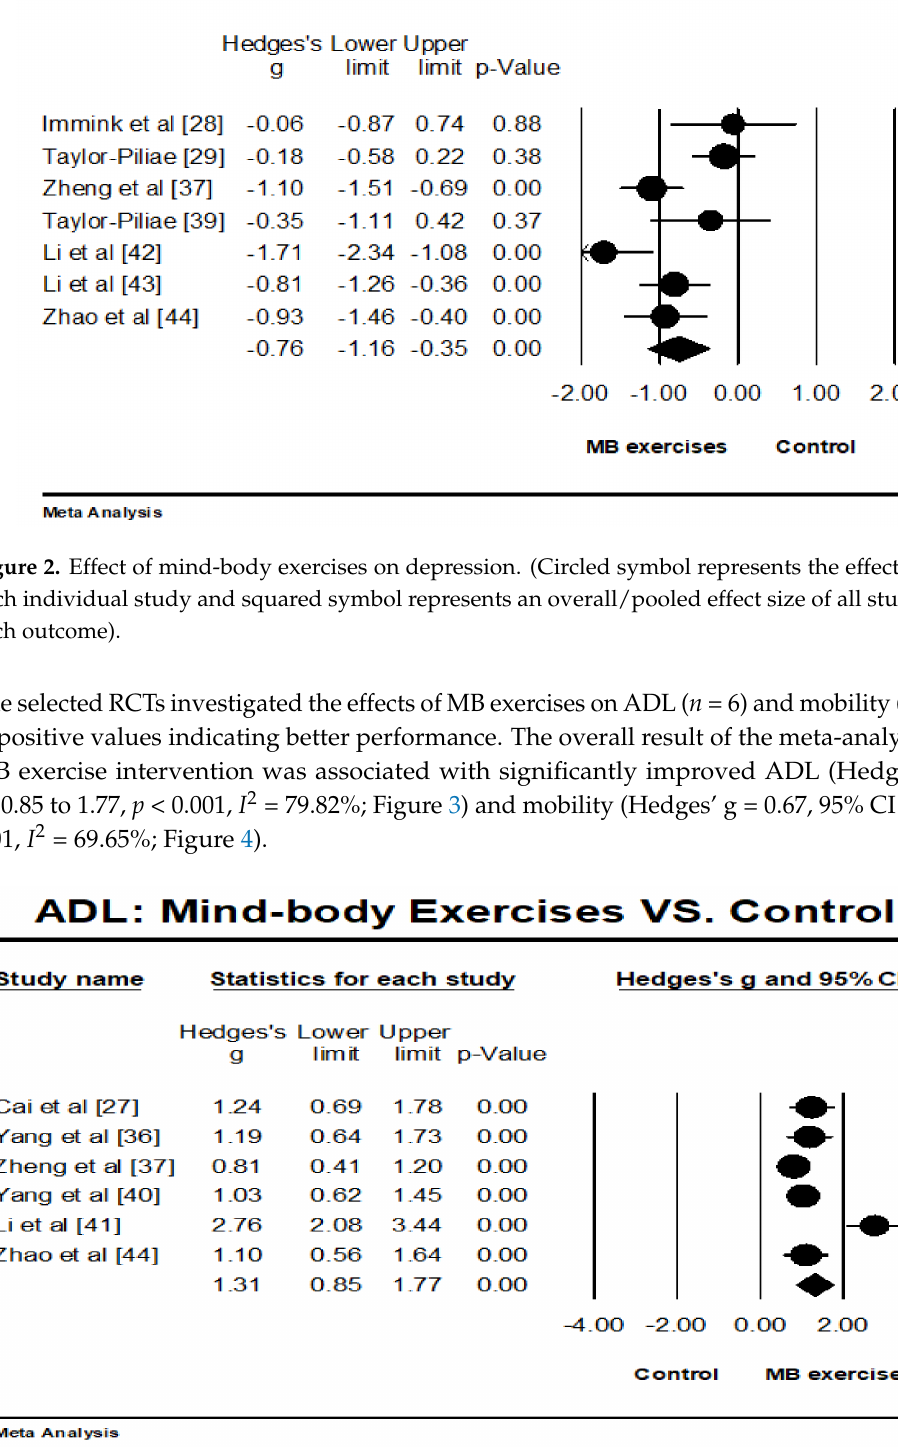
Figure 3. Effect of mind-body exercises on activities of daily living. ADL: activities of daily living. (Circled symbol represents the effect size of each individual study and squared symbol represents an overall/pooled effect size of all studies on each